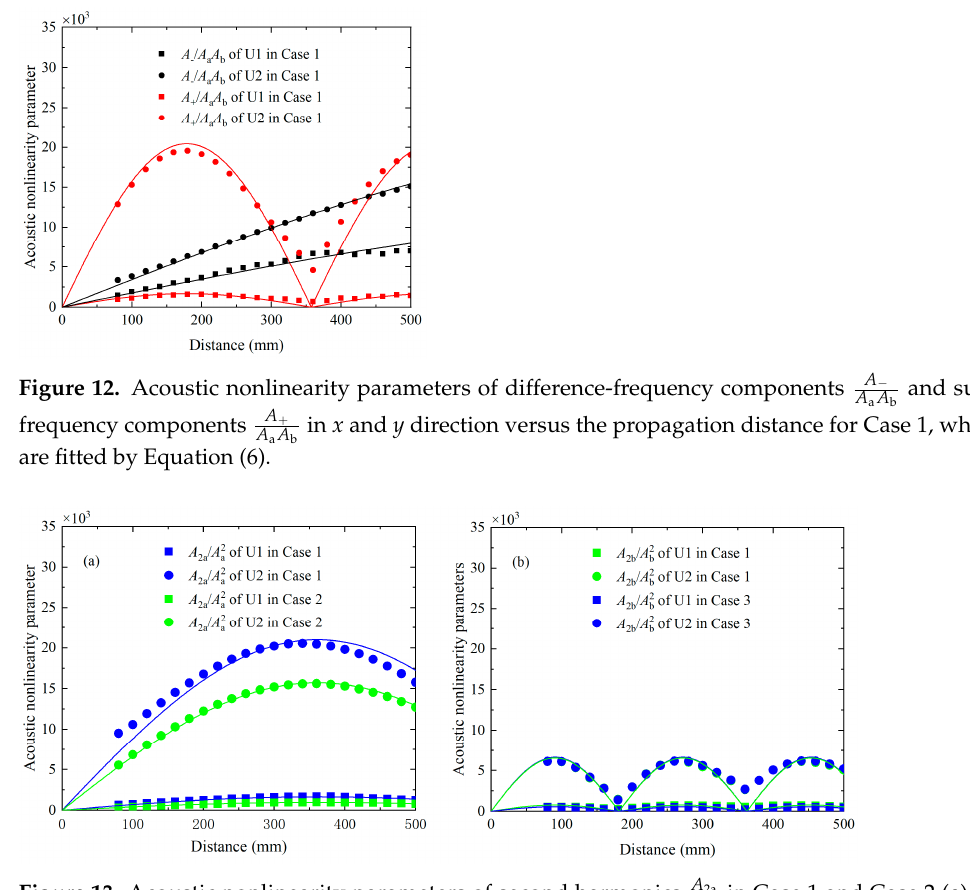
in Case 1 and Case 2 ( a ), as A 2 a